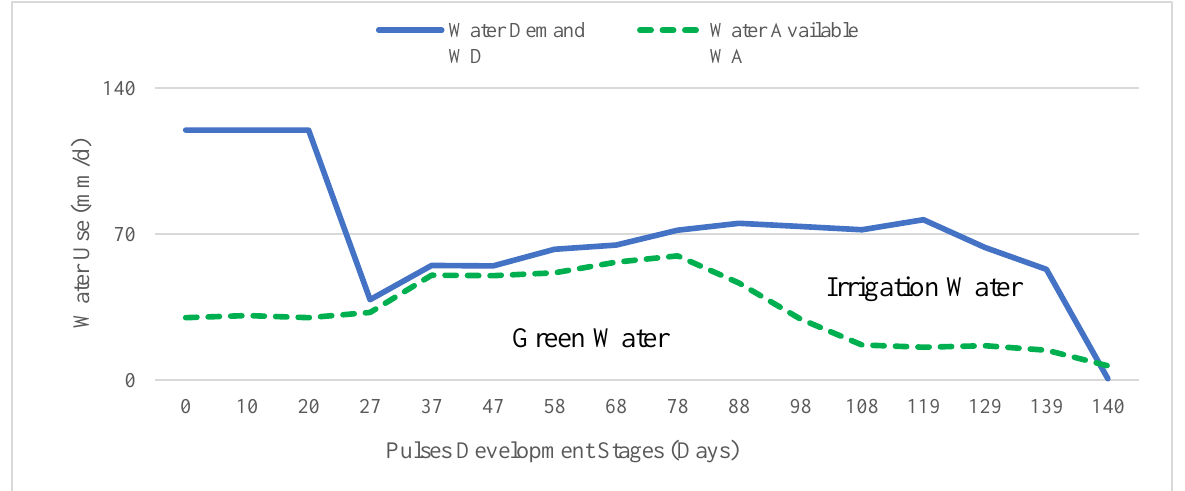
Figure A5. Graphical representation of water demand and water available for pulses. Crop Water Depth (CWD), Crop Water Use (CWU) Calculation: The irrigation require- ment ( IR ), Green Crop Water Depth ( CWD green ) and Blue Crop Water Depth ( CWD blue ) have been calculated using Equations (A4)–(A6), respectively. The irrigation requirement ( IR ) or Blue Crop water depth ( CWD blue ) is calculated as the difference between crop Water De- mand ( WD ) and Water Available ( WA ) which is Equation (A4). The irrigation requirement is zero if effective rainfall or Water Available is larger than the crop water requirement or Water Demand [42]. This